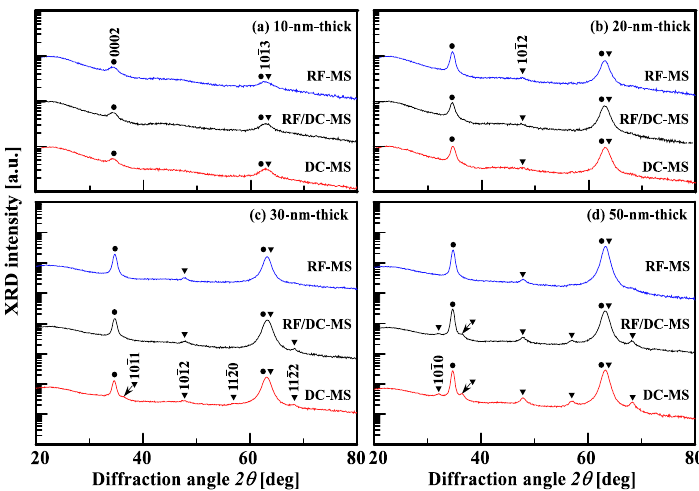
Figure 4. Out-of-plane grazing-incidence XRD patterns of ( a ) 10, ( b ) 20, ( c ) 30, and ( d ) 50-nm-thick AZO films deposited by DC magnetron sputtering (DC–MS) and RF/DC magnetron sputtering (RF/DC–MS) at a power ratio of 0.14, and RF magnetron sputtering (RF–MS).